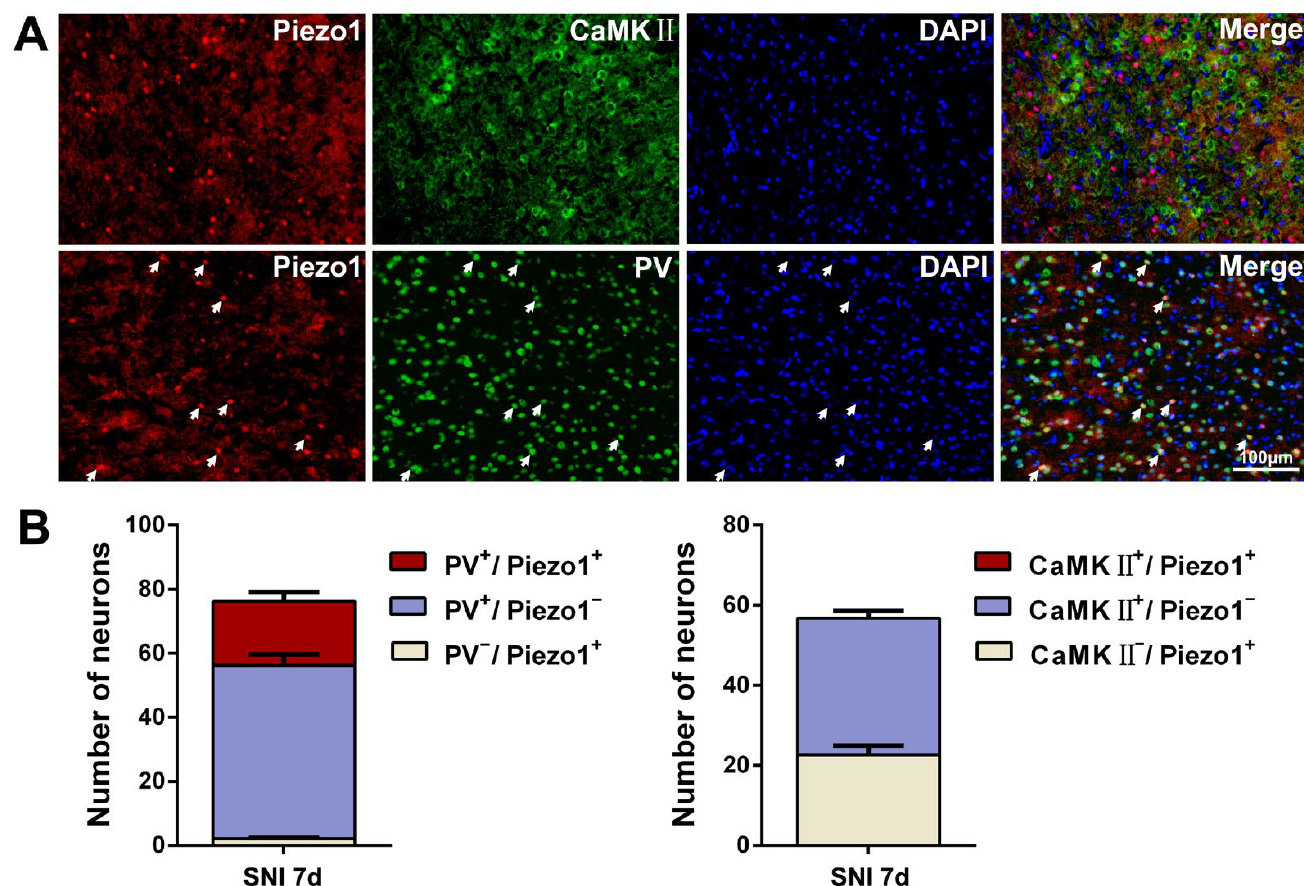
Figure 2. SNI-induced Piezo1 is preferentially expressed in ACC PV-INs. ( A ) Representative double staining image showing the overlap (white arrows) of Piezo1-IR (red) with PV (inhibitory interneuron marker, green, below), but not with CaMK II (glutamate neuronal marker, green, top), 7 d after SNI. The color of co-localization is yellow. Blue fluorescence is from DAPI, a nuclear counterstain. Scale bar = 100 μm. ( B ) Quantitative analysis of Piezo1-IR neurons co-localized with PV-IR and CaMK Ⅱ -IR neurons.